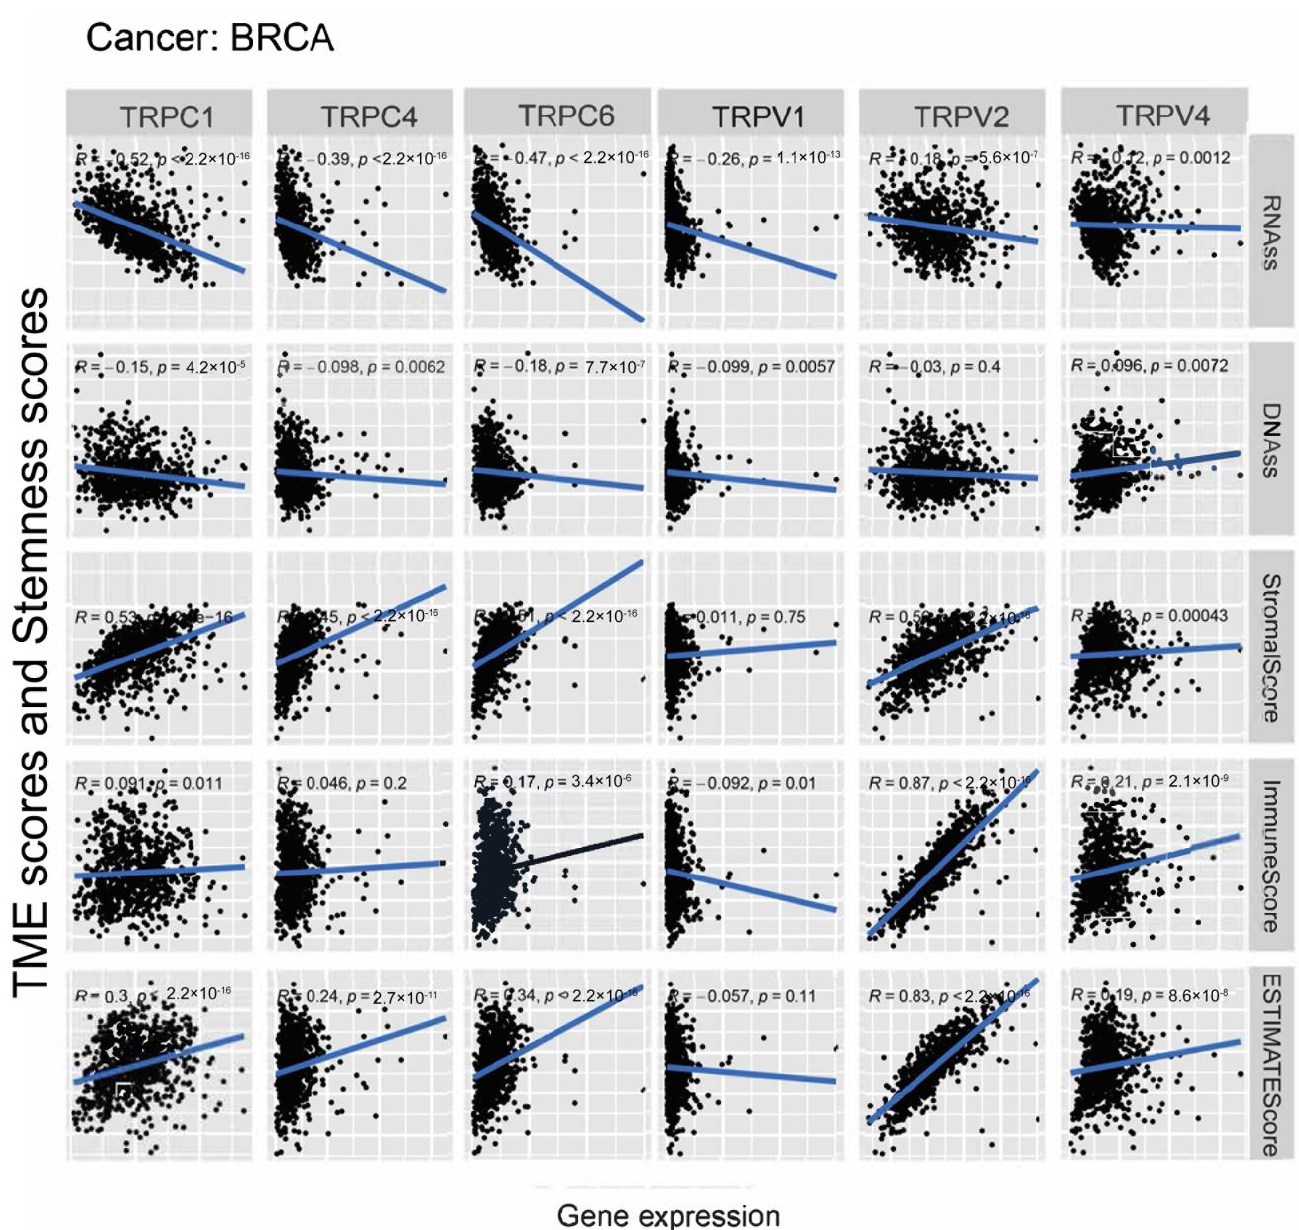
Figure 5. Correlation analysis of the expression of TRP family genes with RNAss, DNAss, stromal score, immune score, and ESTIMATE score in BRCA.